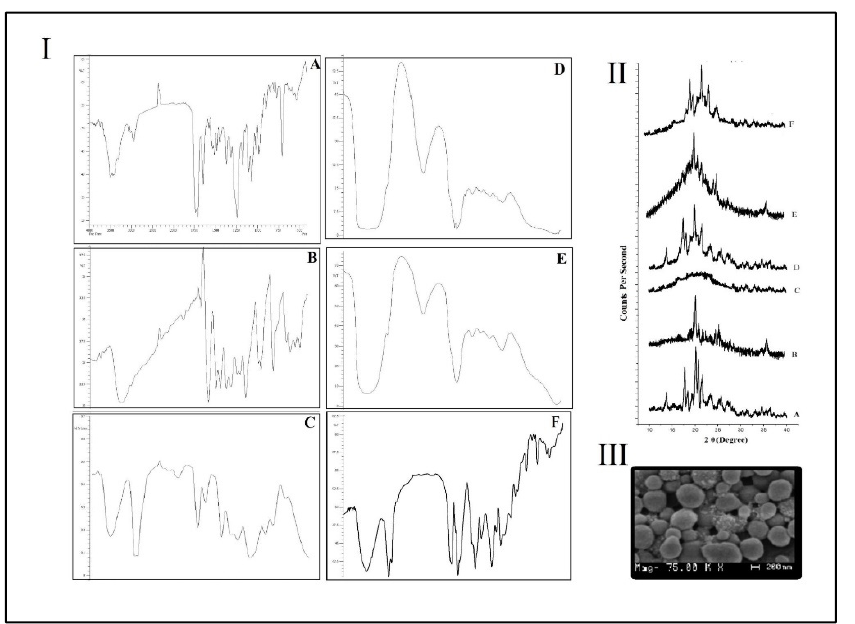
Figure 4. ( I ) FT-IR Spectrum of ( A ) PAX; ( B ). RESV; ( C ) Placebo; ( D ) PAX PNPs; ( E ) RESV PNPs; ( F )